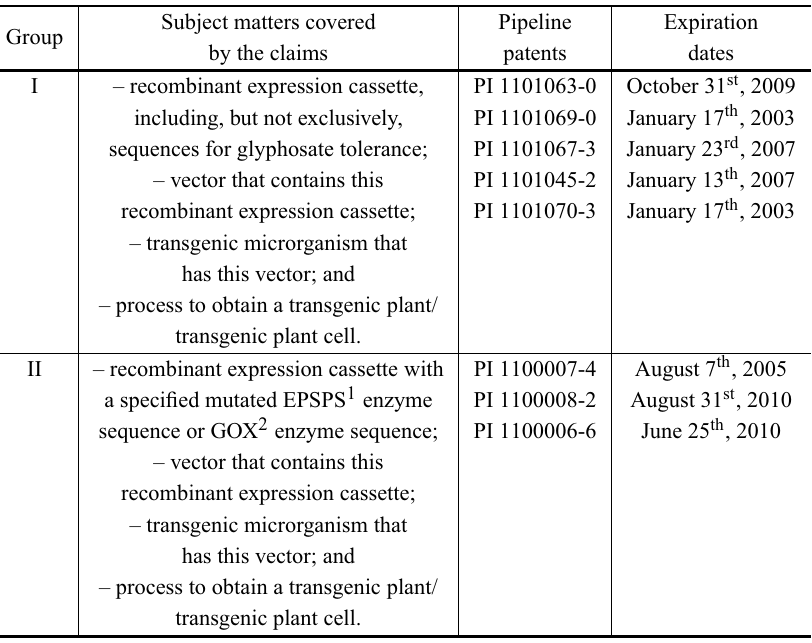
The scope of protection of the claims’ pipeline patents of groups I and II, the pipeline patents and their expiration